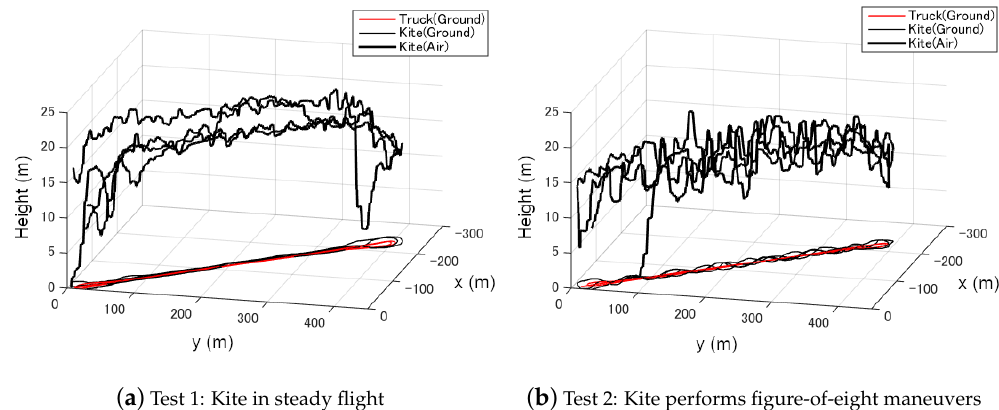
( b ) Test 2: Kite performs figure-of-eight maneuvers Figure 8. A 3D visualization of the kite for tests 1 and 2.